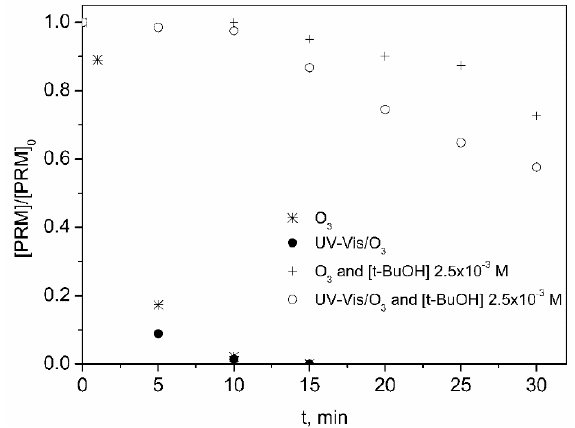
Figure 3. Influence of t-BuOH on the elimination of PRM by O 3 and UV-Vis / O 3 processes in ultrapure water. Experimental conditions: [PRM] 0 = 5 mg L − 1 ; [t-BuOH] = 2.5 × 10 − 3 M; pH 0 ~6 (natural pH); Q m,O3 = 3.3 mg min − 1 ; T = 20–30 °C; I UVA-Vis = 8.2 × 10 − 5 Einstein L − 1 s − 1 .